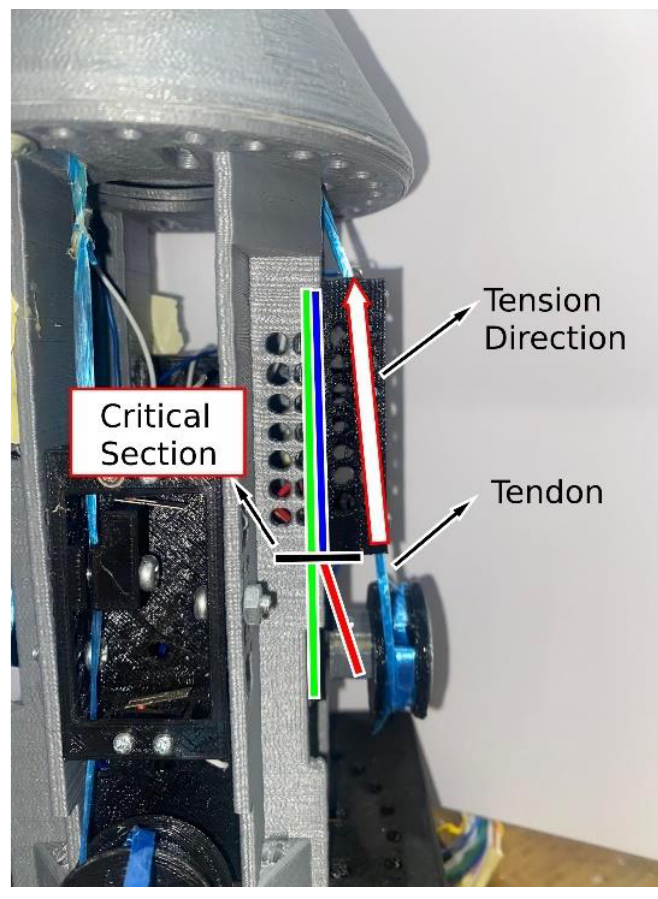
Figure 7. Illustration showing the critical section of the bending moment in the actuator housing due to the tension in the tendon.